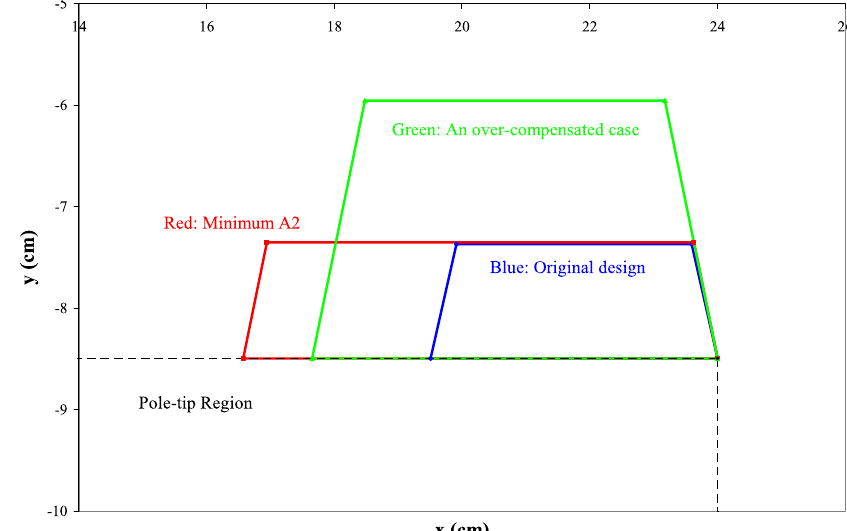
FIG. 14. (Color) Cross sections of three longitudinal shims.